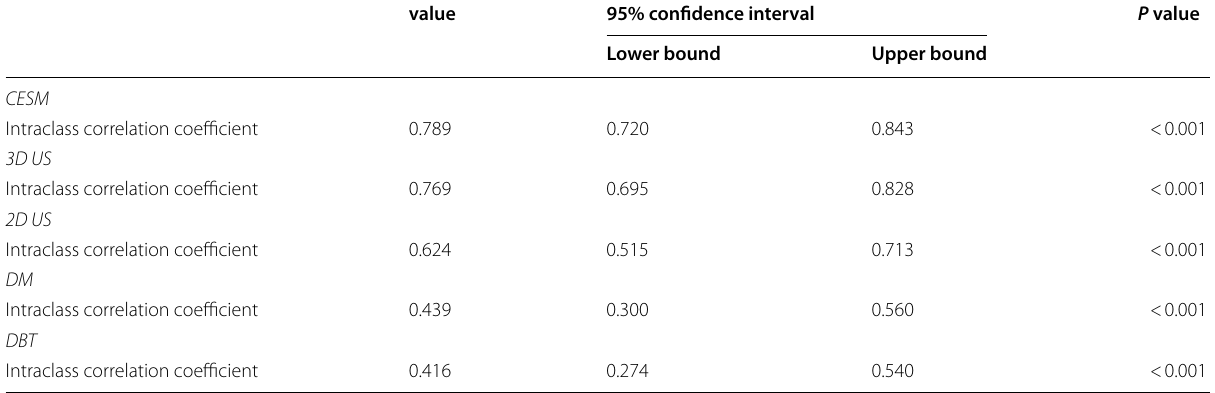
Table 3 The agreement between the sizes measured by different modalities and the